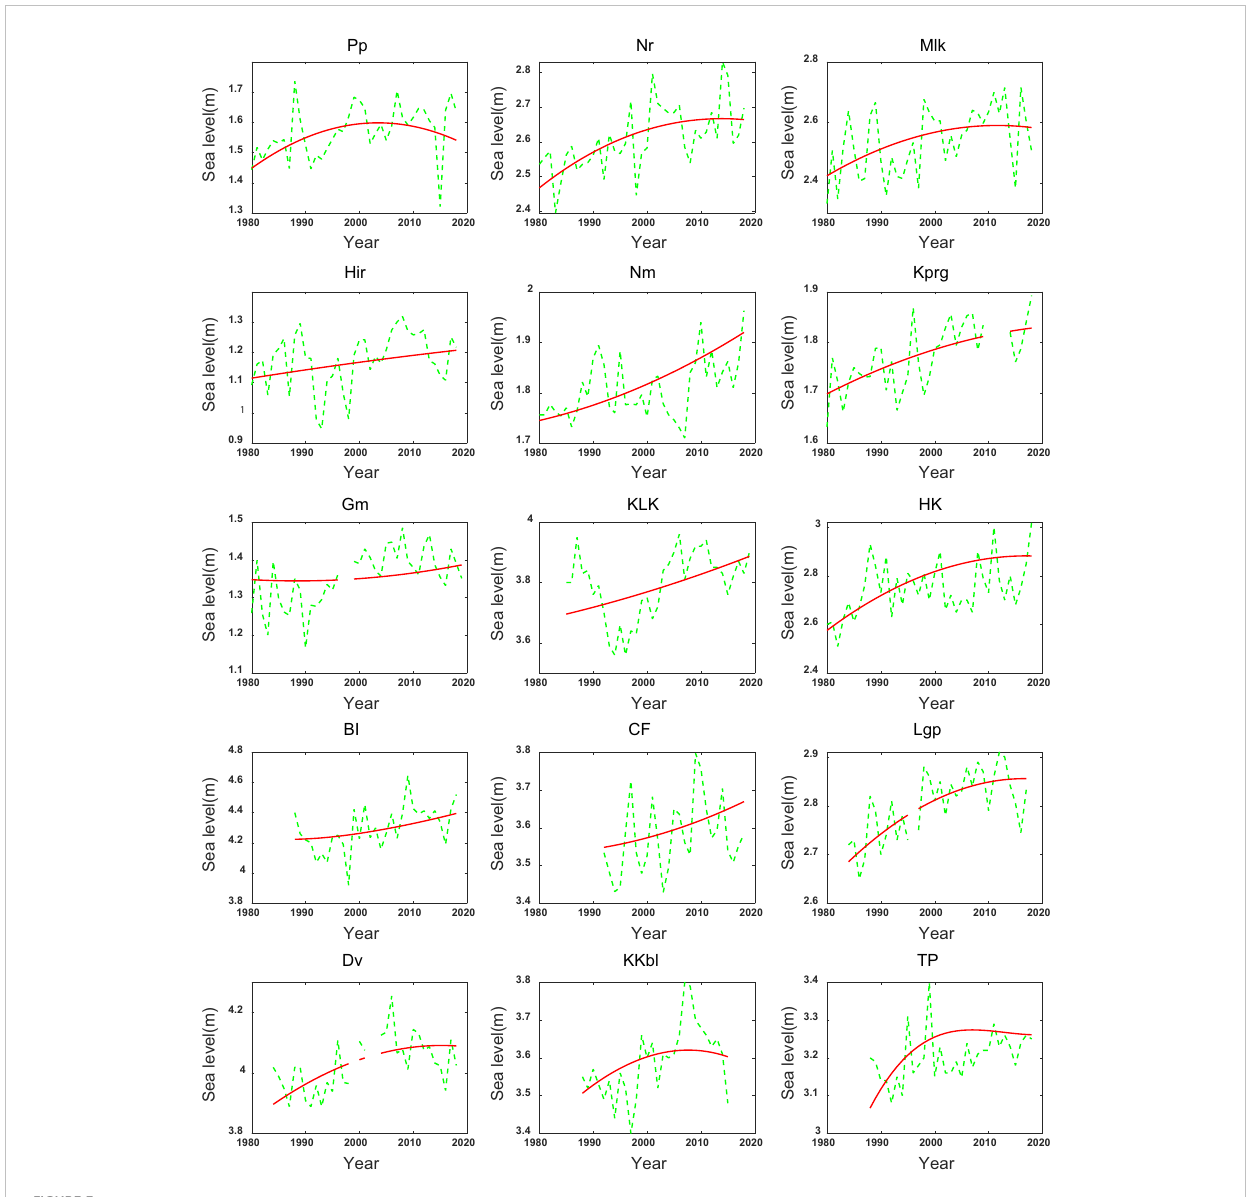
FIGURE 3 Long term trends of the ESLs at 15 tide gauges (red lines), 99.9% levels of the observed sea levels (green